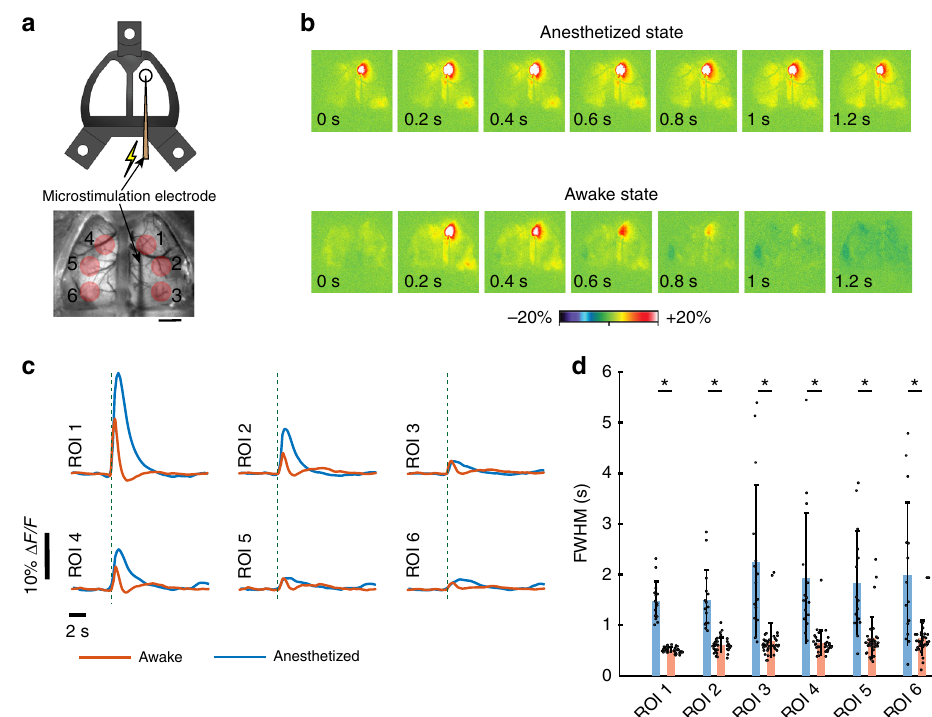
Fig. 6 Cortical microstimulation during wide- fi eld Ca 2 + imaging. a Top: Cartoon schematic of a microstimulation electrode inserted through a perforated See-Shell. Bottom: a wide- fi eld image showing microstimulation electrode inserted at the primary motor cortex. Red circles indicate regions of interest (ROIs) analyzed. Scale bar indicates 2 mm. b Pseudocolor plots of normalized change in fl uorescent intensity in response to primary motor cortex microstimulation. Top: under iso fl urane anesthesia, bottom: awake. Post-stimulation time stamps are indicated at the bottom of each image. c Average normalized Ca 2 + activity traces in response to microstimulation of primary motor cortex for different ROIs indicated in a . ROI 1: primary motor cortex and stimulation site; ROI 2: ipsilateral somatosensory cortex; ROI 3: ipsilateral visual cortex; ROI 4: contralateral motor cortex; ROI 5: contralateral somatosensory cortex; and ROI 6: contralateral visual cortex. Dashed lines indicate the time of stimulus. d Bar plots overlaid with the dot plots of full width at half maximum in the different ROIs under anesthetized and awake conditions. Error bars indicate s.d.; Student's t -test, *indicates p <